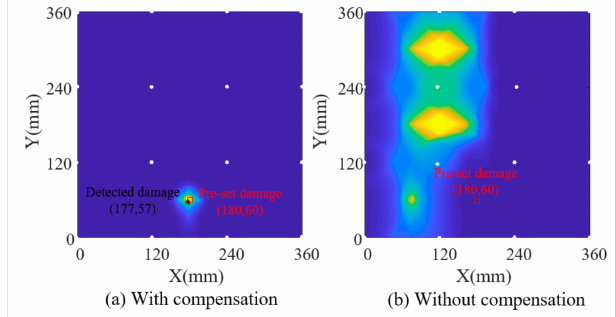
Figure 11. Damage identification results of simulation model 3.